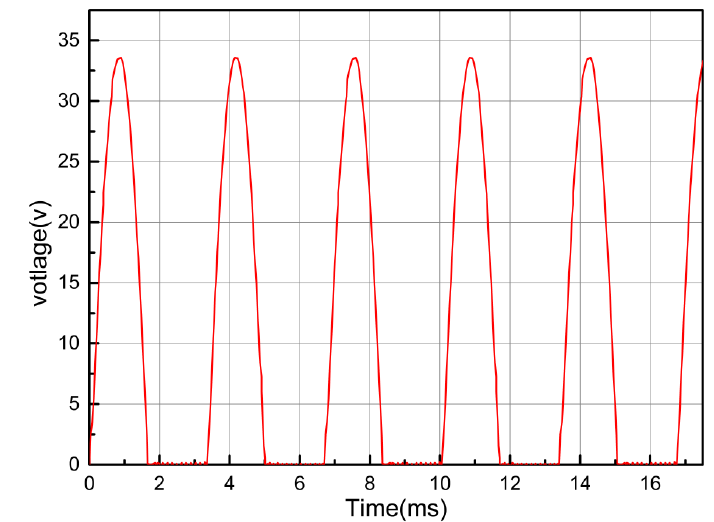
Figure 8. Output voltage waveform at 3000 r/min and no-load.